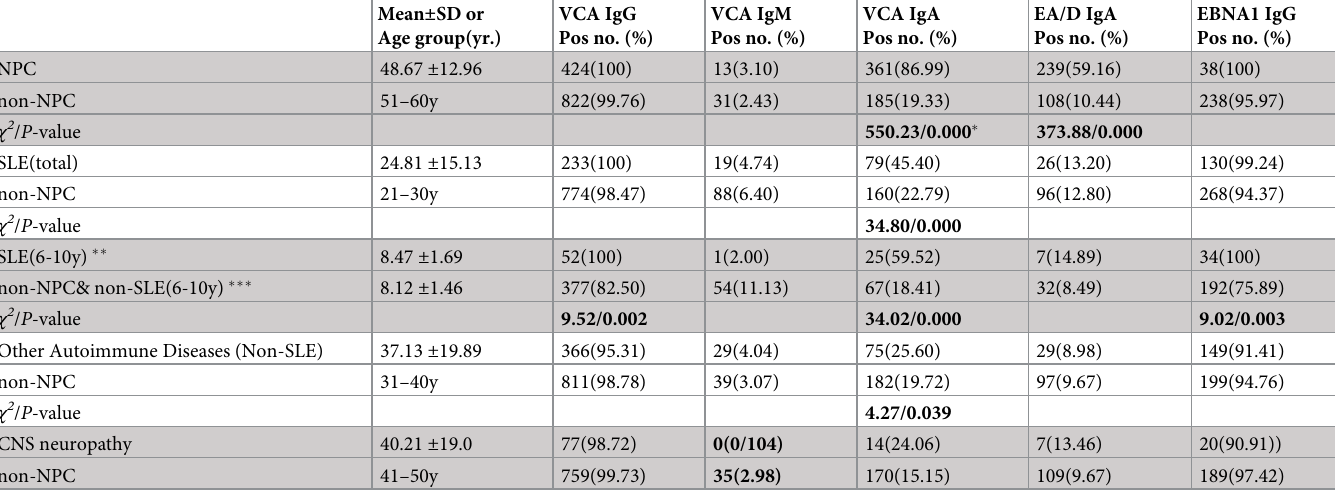
665/6252, χ 2 = 13.11, P = 0.000). The seroprevalence of anti-EBV antibodies among various patients, including those with NPC, SLE, other autoimmune diseases (non-SLE) as well as CNS neuropathy are presented in Table 4. The prevalence of both VCA IgA and EA/D IgA in NPC patients were significantly Table 4. Comparison of anti-EBV antibodies in different patients visiting the PUMC Hospital, Beijing, 2013–2017. Mean ± SD or Age